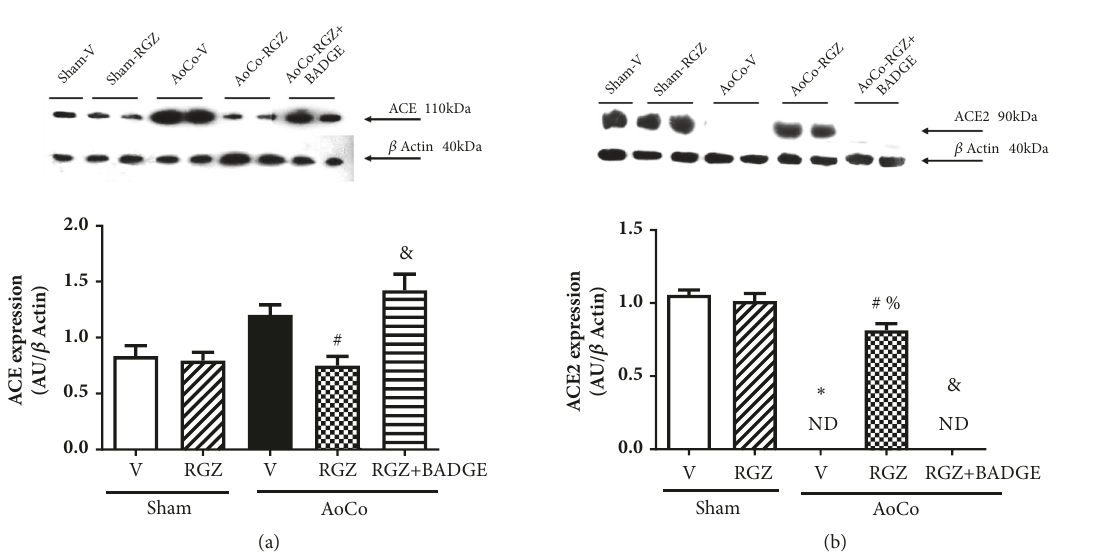
Figure 3: Effect of rosiglitazone (RGZ) on aortic angiotensin converting enzyme (ACE) (a) and ACE2 (b) expression. The images show representativewestern blots. The protein expression was evaluatedin homogenateof aorta from sham or aorticcoarctated(AoCo) rats treated with vehicle (V), rosiglitazone (5mg/kg, RGZ), or RGZ + bisphenol A diglycidyl ether (120 mg/kg, RGZ+BADGE). The values represent the mean ± SEM (n=6 animals per group). One-way analysis of variance (ANOVA) post Tukey. ∗ P < 0.05 Sham-V vs. AoCo-V, # P < 0.05 AoCo-V vs. AoCo-RGZ, % P < 0.05 Sham-RGZ vs. AoCo-RGZ, and & P < 0.05 AoCo-RGZ vs. AoCo-RGZ+BADGE. ND: not